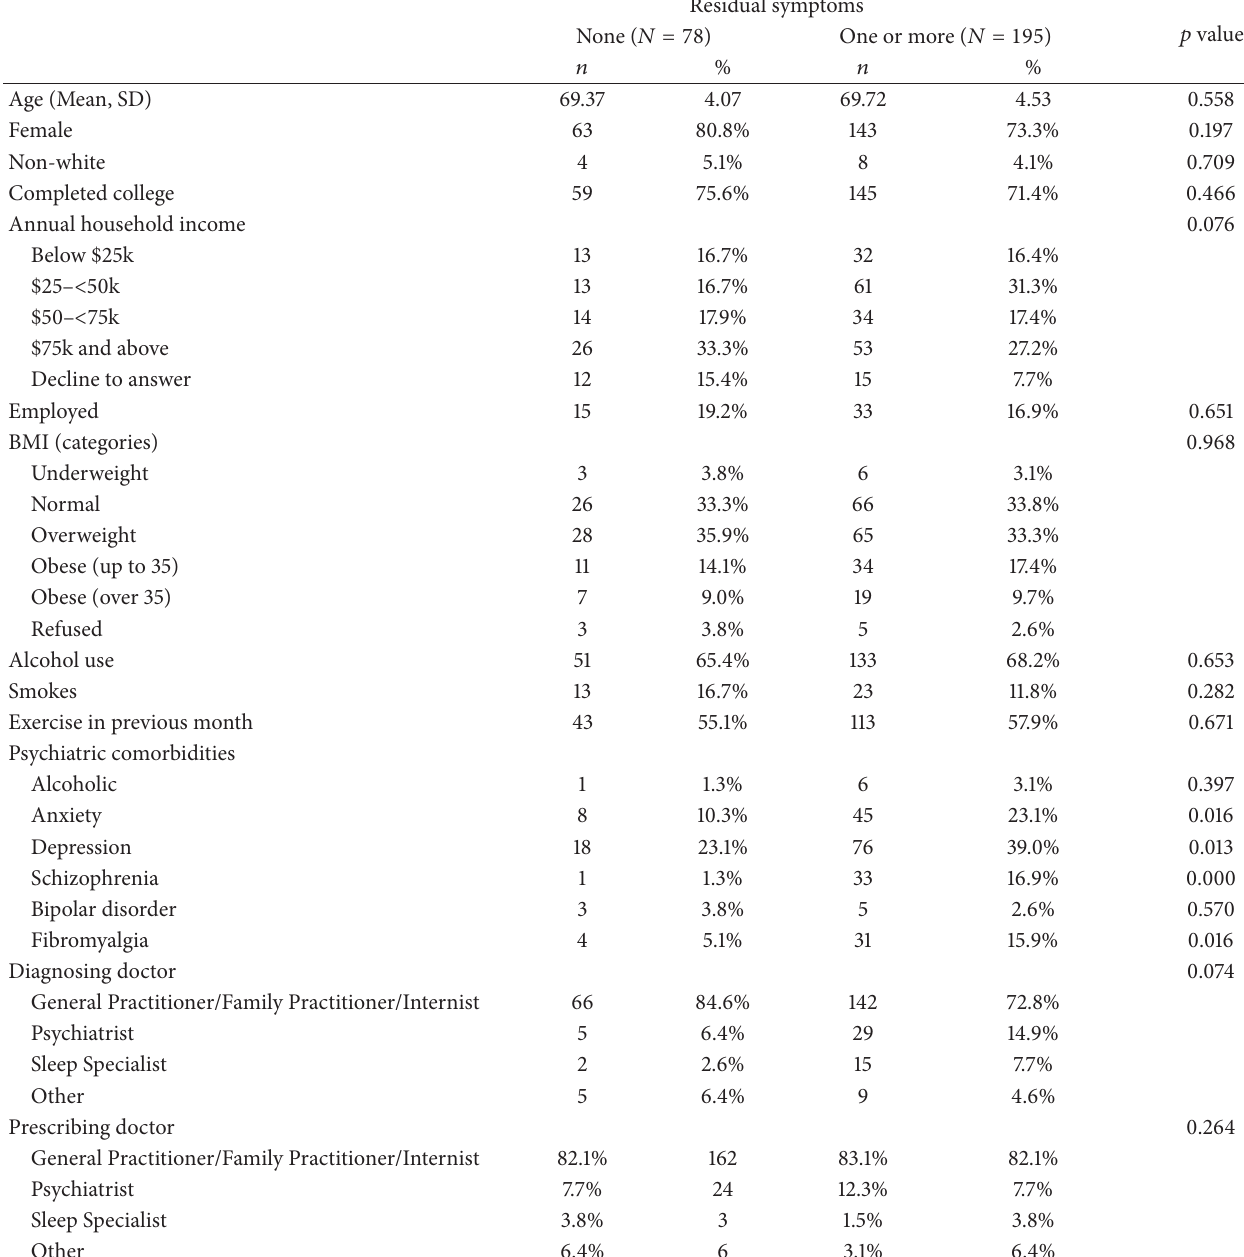
Table 4: Respondent characteristics by experience of residual symptoms in respondents aged 65 and